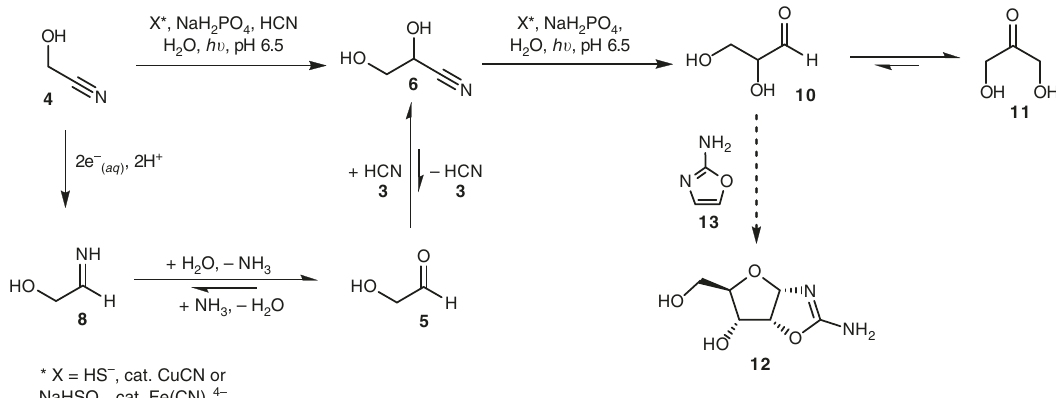
Fig. 1 Photochemical reduction of cyanohydrins. Solvated electrons and/or H (cid:129) can ef fi ciently reduce cyanohydrins. These reactions are promoted by Cu + or Fe 2 + ions and a sulfurous stoichiometric reductant under UV